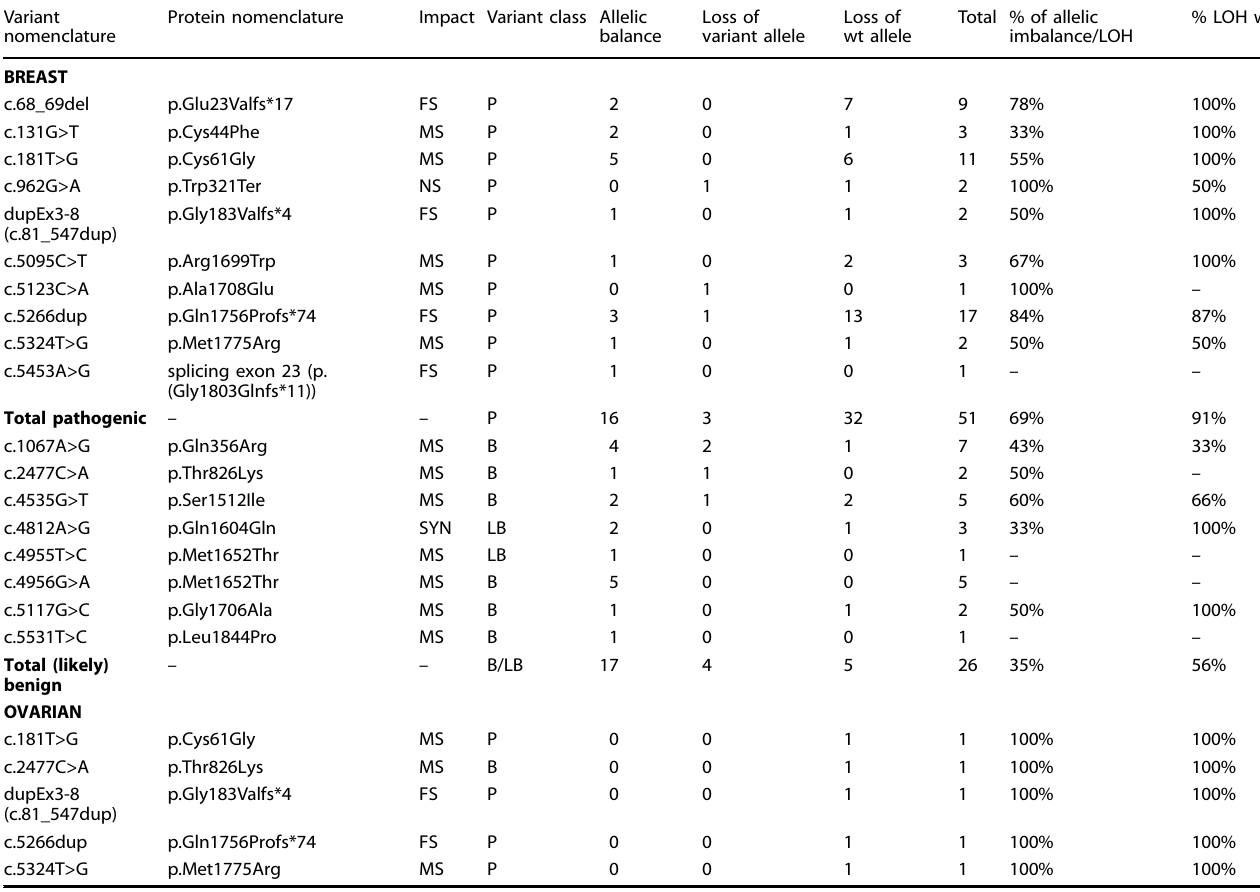
Table 2. LOH breast/ovarian cancer results from pyrosequencing or NGS experiments for pathogenic (P), benign (B), and likely benign (LB) variants.